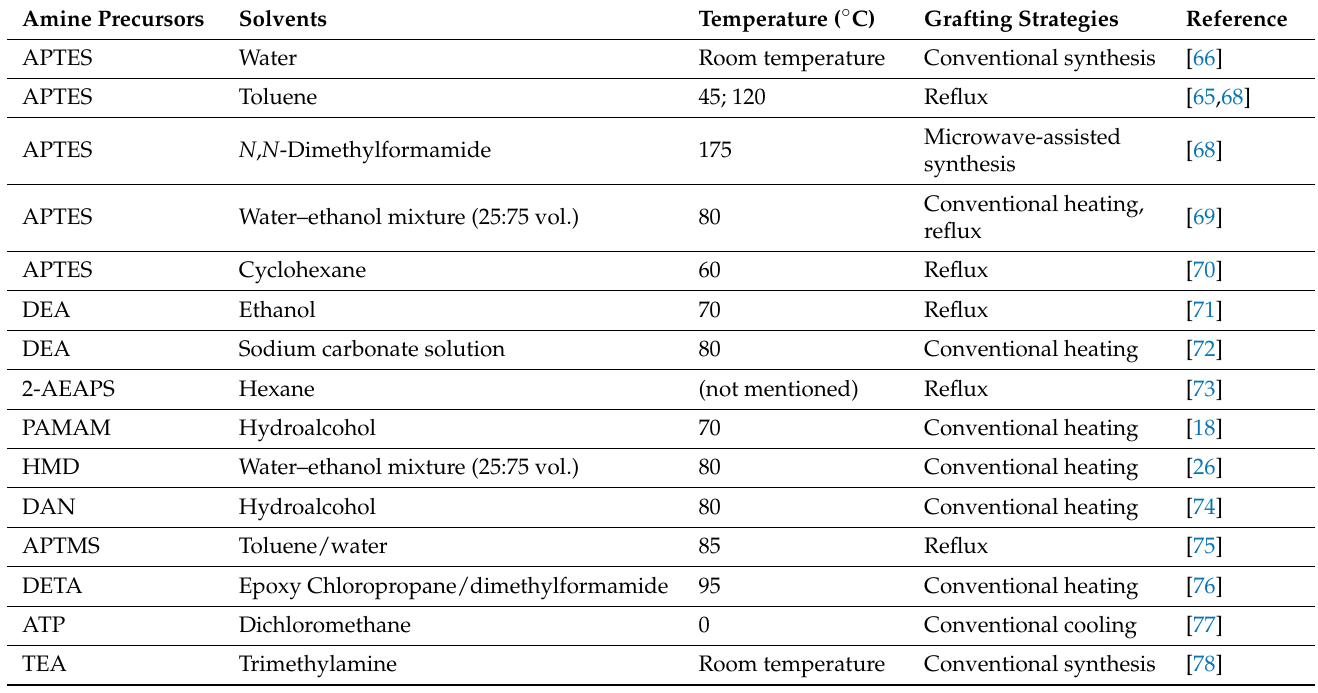
Table 2. Summary of the solvent, temperature, and grafting methods of various